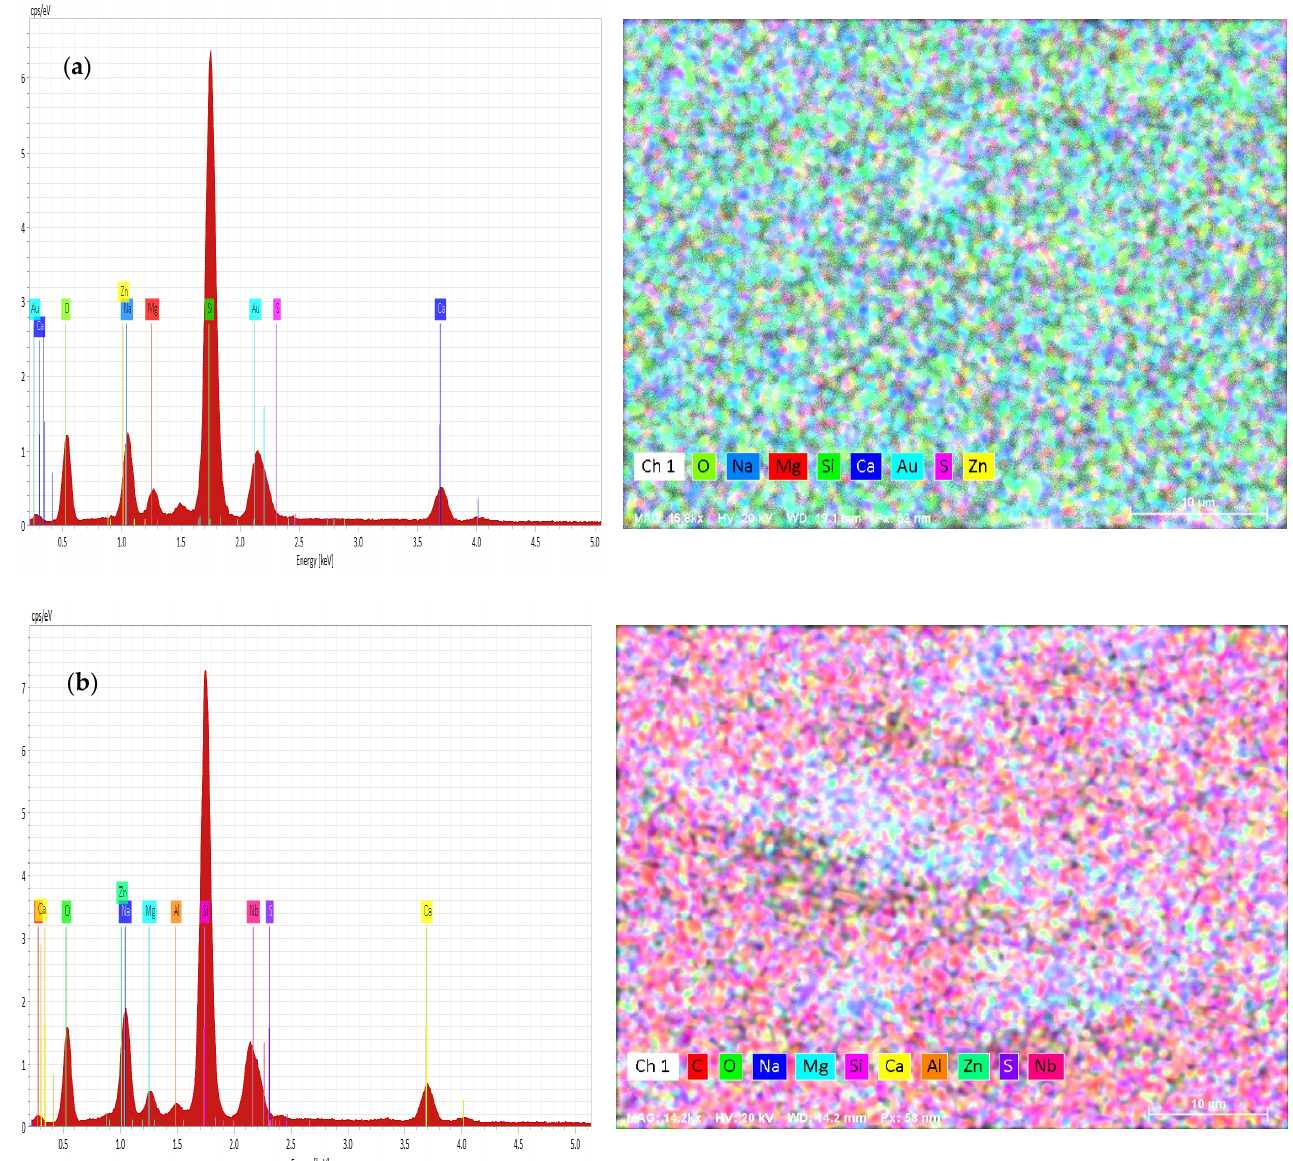
Figure 4. ( a ) EDAX of as-deposited ZnS thin films and ( b ) EDAX of ZnS thin films annealed at 300 °C.